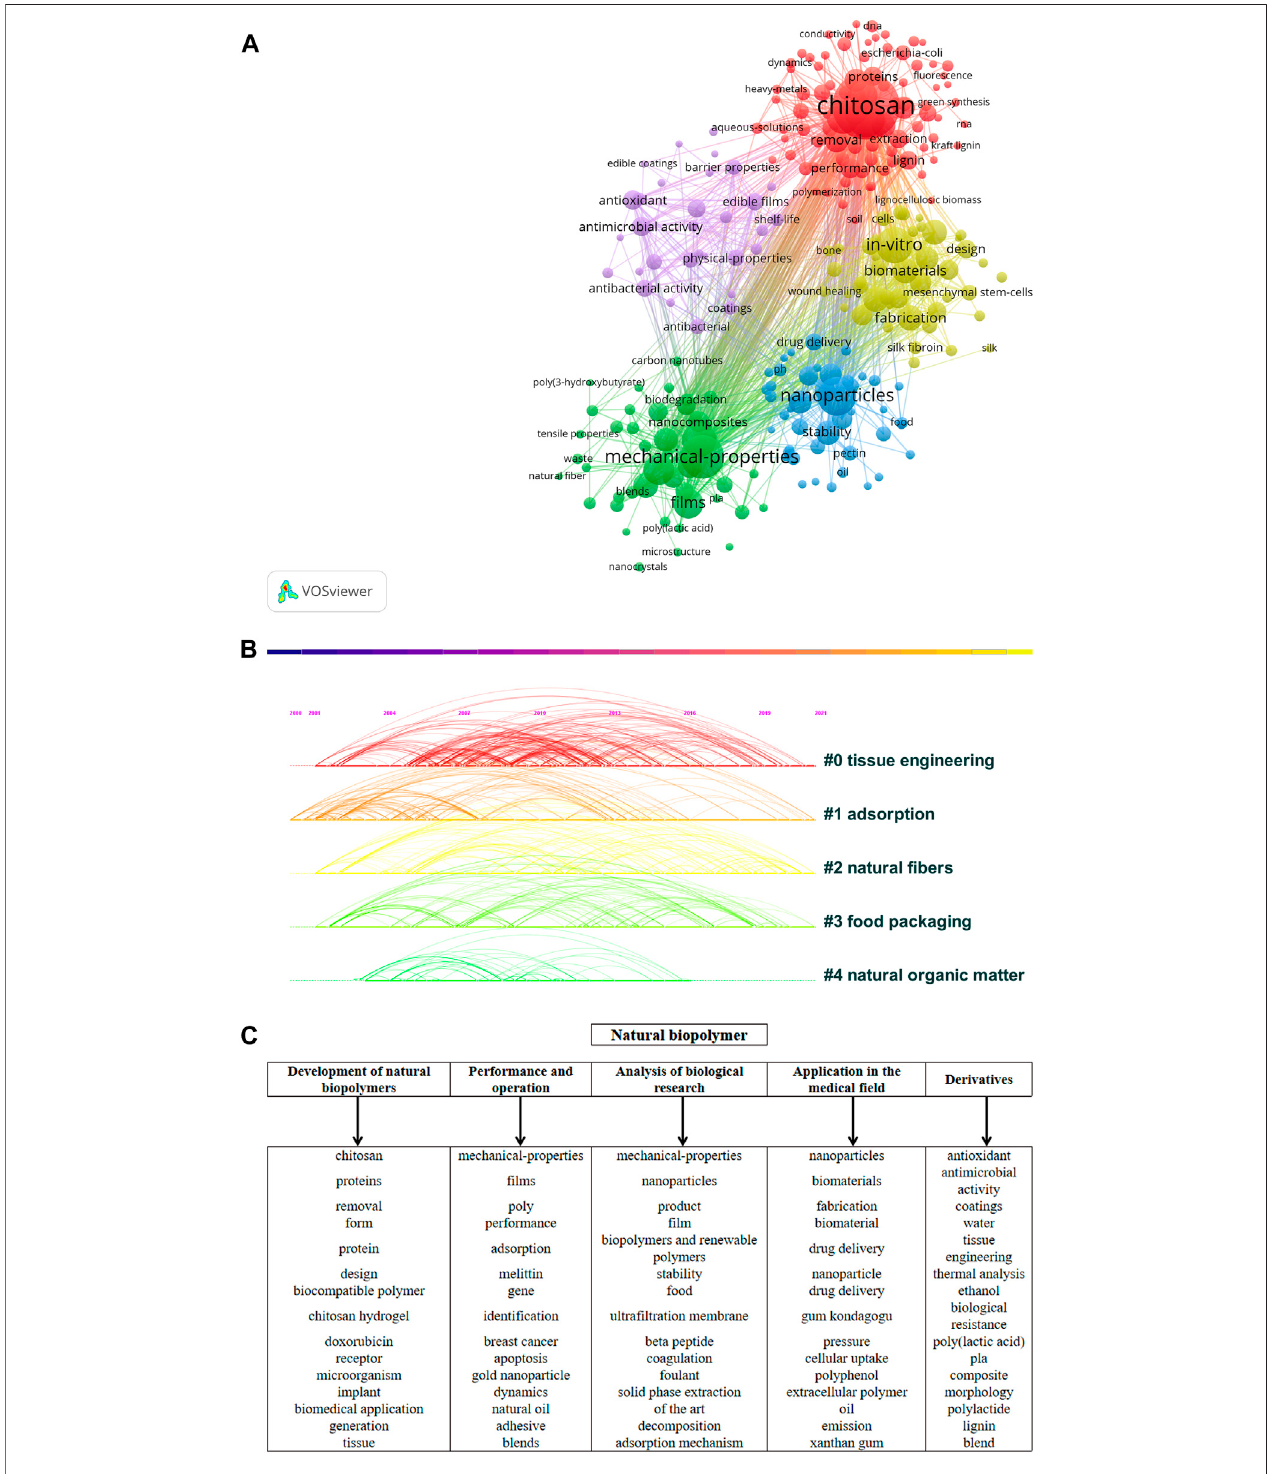
FIGURE6| Keywordco-occurrenceandclusteringknowledgegraph. (A) BasedonVOSviewersoftware(frequency ≥ 20). (B) BasedonCiteSpacesoftware(top5 categories). (C) Knowledge structure graph.